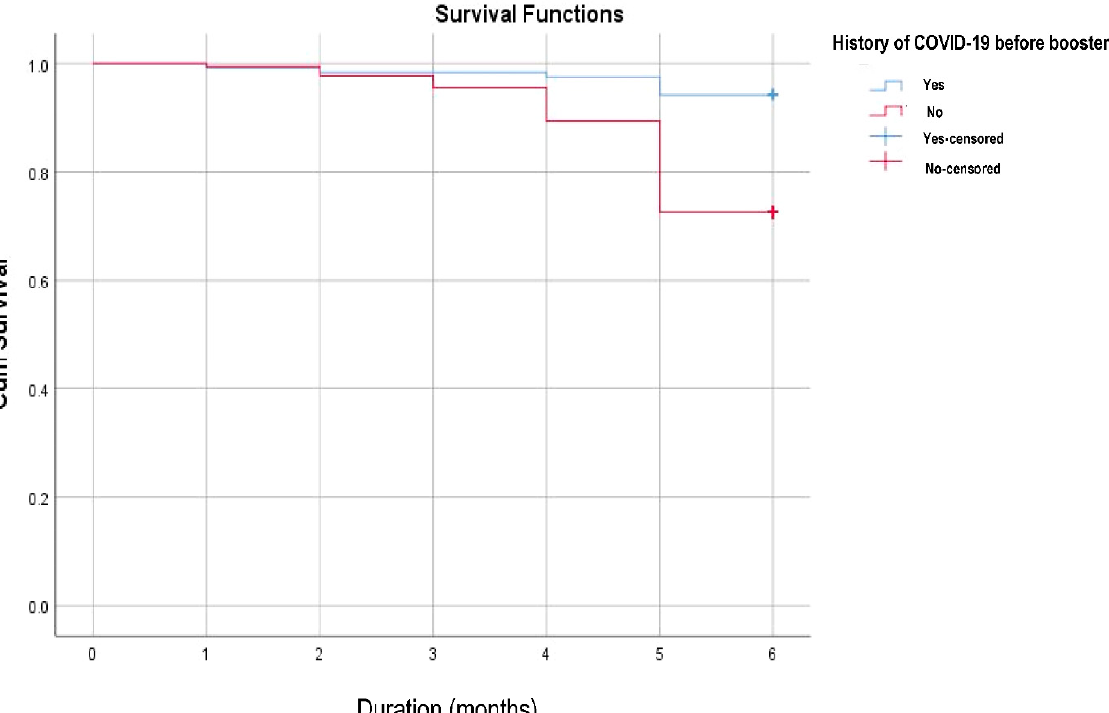
Figure 4. Confirmed COVID-19 cases in Indonesia (August 2021–April 2022) based on World Healh Organization and COVID-19 Response Acceleration Task Force Republic of Indonesia data. As seen in this figure, there was a substantial increase in COVID-19 cases from December 2021 to February 2022. Indonesia experienced a third wave of COVID-19 between these months, which was charac- terized by the omicron variant.